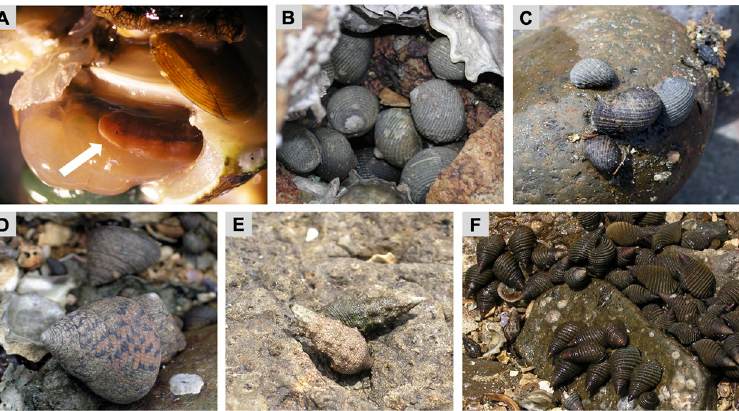
Fig 1. Symbiotic flatworm Paraprostatum echinolittorinae (Platyhelminthes: Turbellaria: Polycladida) and its snail hosts. (A) A flatworm inside the mantle cavity of snail host ( Tegula pelllisserpentis ), as indicated by a white arrow. Five species of intertidal snails common on the Pacific Coast of Panama including (B) Nerita scabricosta , (C) N . funiculata , (D) Tegula pelllisserpentis , (E) Cerithium stercusmuscarum , and (F) Planaxis planicostatus .